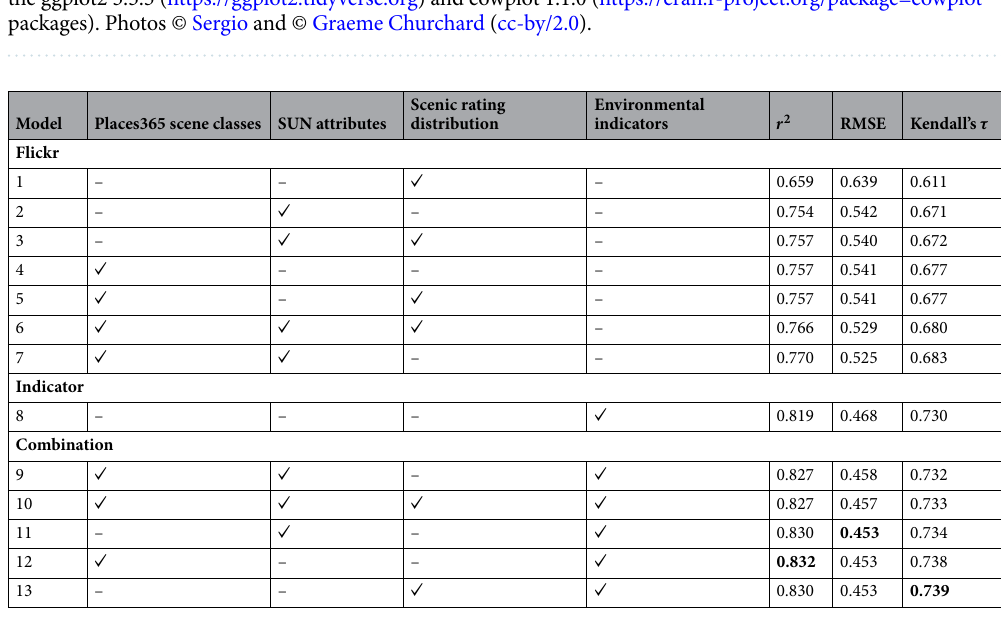
Table 1. Scenicness model accuracy results on the gridded test set at 5 km resolution, derived from the SoN database.